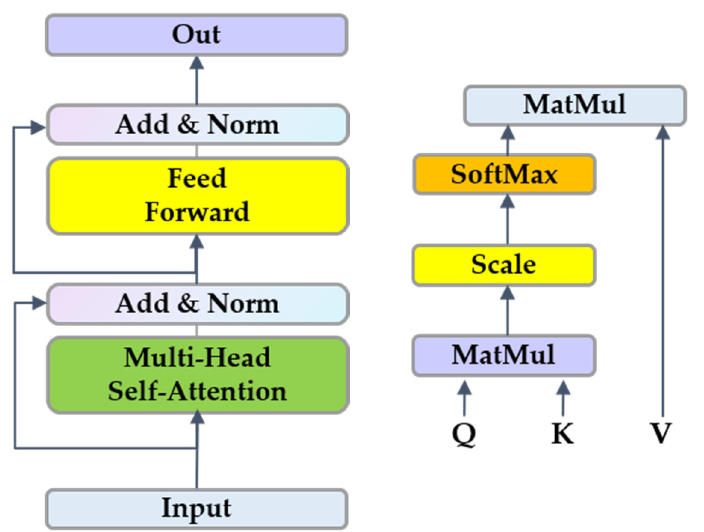
Figure 7. Performer (Transformer) encoder architecture and self-attention schematic